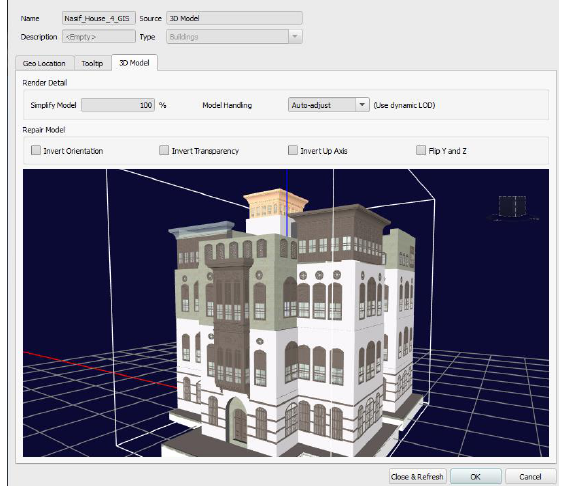
Figure 8: the 3D JHBIM model in Autodesk InfraWorks.